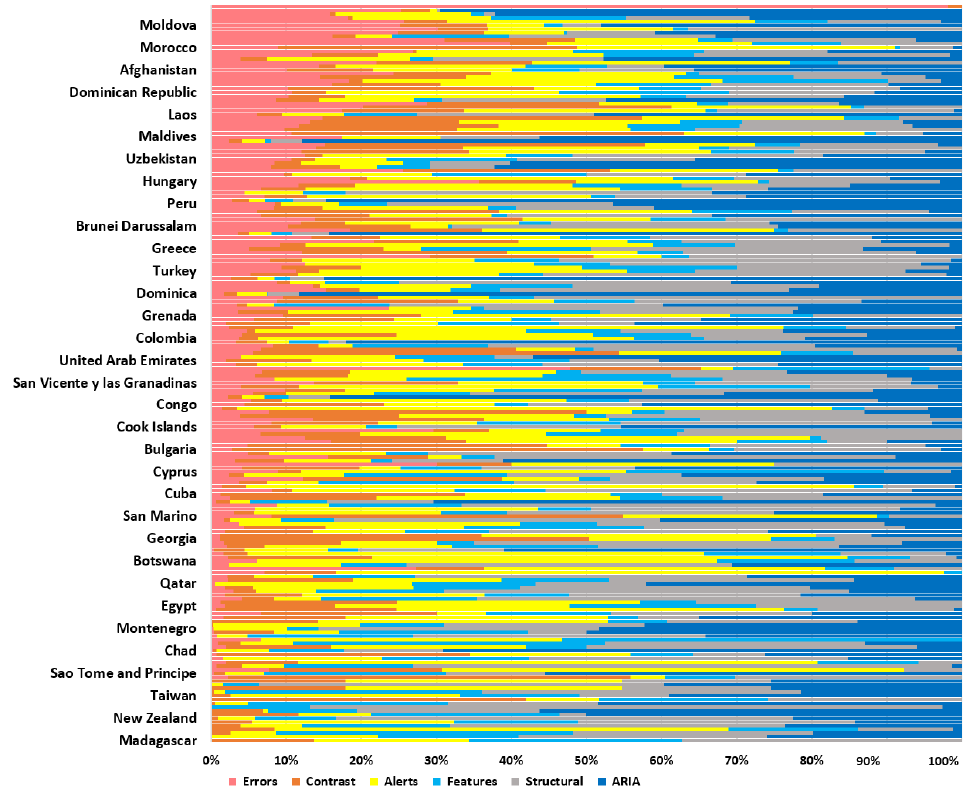
Figure 2. Summary of 199 websites and variables analyzed with WAVE.